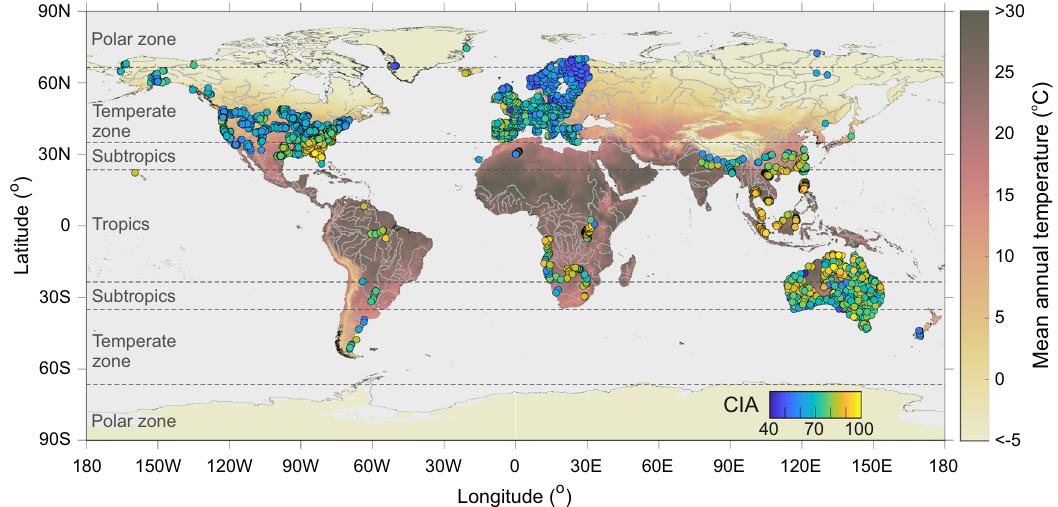
Fig. 1 Geographic locations of compiled weathering index data in fi ne-grained sediments. The symbol color indicates the value of the chemical index of alteration (CIA; n = 3828). Data source of CIA is described in Methods. A sub-sample set ( n = 2989) collected from small- and median-sized catchments was used for geospatial analysis and discussion on environmental controls (Methods). The global map of mean annual temperature is shown for comparison. At fi rst glance, high CIA values (yellow symbols) are in general limited to the tropics and subtropics.